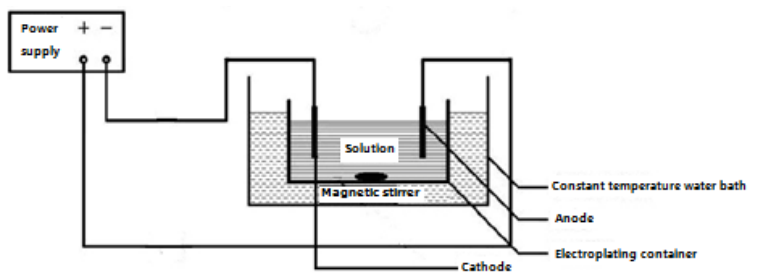
Figure 1. Schematic diagram of electrodeposition device.